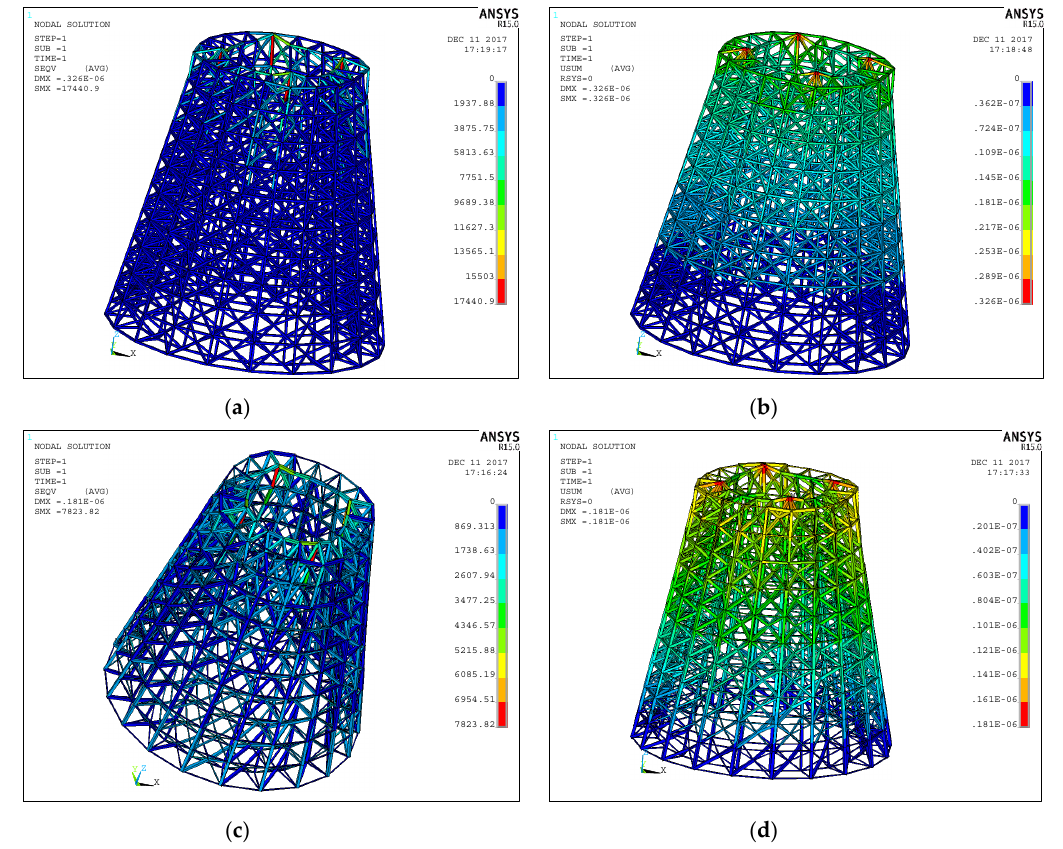
Figure 18. Analysis results: ( a ) von Mises stress for initial structure; ( b ) displacement for initial structure; ( c ) von Mises stress for optimized hollow round platform; and ( d ) displacement for optimized hollow round platform.